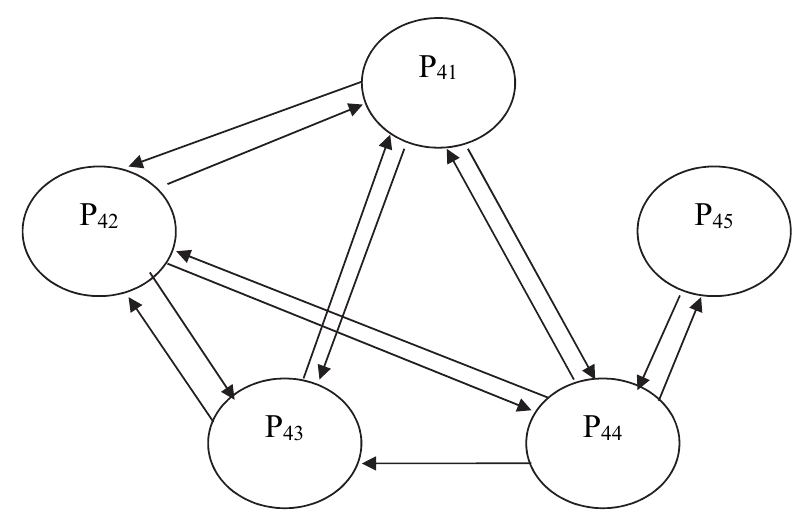
Fig. 6. Digraph for Political, Legal and Visa related